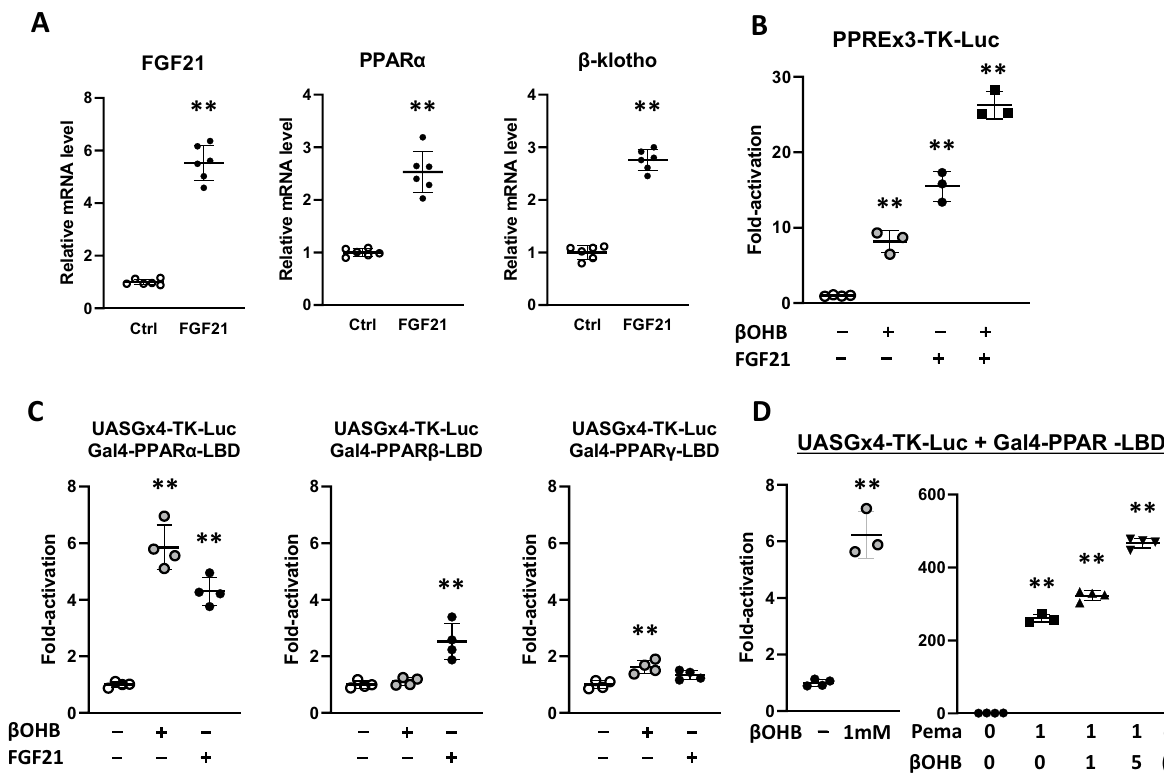
Figure 2. Effects of FGF21 on signaling molecules and transactivating function of PPARα. ( A ) mRNA levels for FGF21, PPARα and β-klotho were compared between the vehicle (ctrl) and FGF21 (10 ng/mL)-treated cardiac myocytes. Data are mean ± SD (n = 6). **p < 0.01 vs control analyzed by unpaired Student’s t-test. ( B ) Cultured neonatal rat ventricular cardiac myocytes were transfected with the reporter constructs contained three copies of PPRE in front of TK promoter. Following transfection, cells were treated with vehicle, 0.5 mM of βOHB, or 10 ng/mL of FGF21 for 24 h before harvest for luciferase activity assay. Luciferase activity was plotted as fold- activation relative to untreated control cells. Data are mean ± SD (n = 3–4). **p < 0.01 vs control analyzed by one- way ANOVA followed by Dunnett correction for multiple comparisons. ( C ) Cultured neonatal rat ventricular cardiac myocytes were transfected with the reporter constructs containing four copies of the UAS G cloned upstream of the TK-Luc reporter (UAS G x4-TK-Luc) together with CMX-Gal-PPARα, CMX-Gal-PPARδ-, or CMX-Gal-PPARγ-LBD. Following transfection, cells were treated with vehicle, 0.5 mM of βOHB, or 10 ng/mL of FGF21 for 24 h before harvest for luciferase activity assay. Luciferase activity was plotted as fold-activation relative to untreated control cells. Data are mean ± SD (n = 4). **p < 0.01 vs control analyzed by one-way ANOVA followed by Dunnett correction for multiple comparisons. ( D ) Neonatal rat ventricular cardiac myocytes transfected with UAS G x4-TK-Luc and CMX-Gal-PPARα were stimulated by βOHB and/or Pemafibrate. Data are mean ± SD (n = 3–4). **p < 0.01 vs control analyzed by unpaired Student’s t-test (left panel) and one-way ANOVA followed by Dunnett correction for multiple comparisons (right